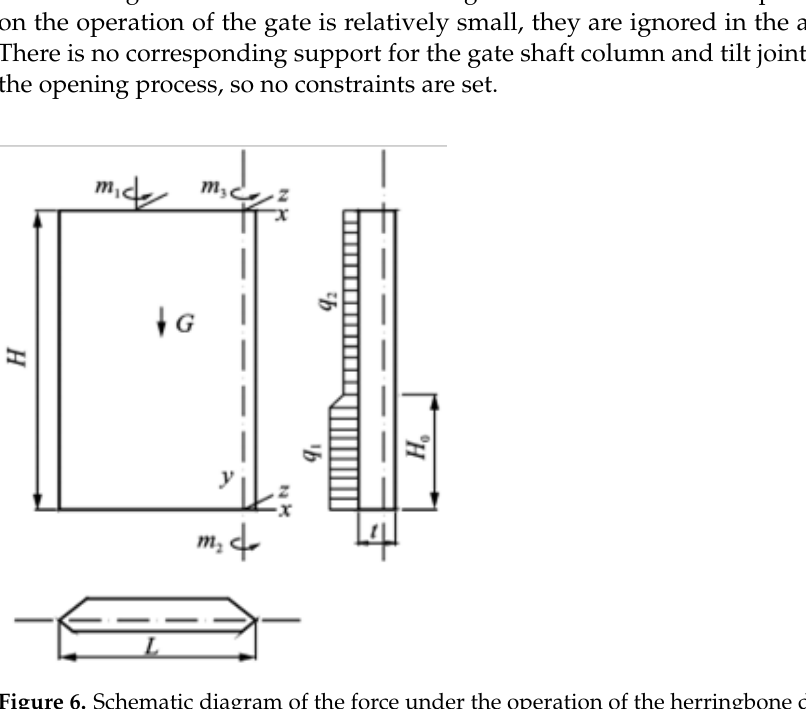
Figure 5. Three-dimensional solid model of gate Pro E.